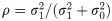
Power of CoCoNet to identify trait relevant tissues in simulations.(A): In scenario I, we selected one of the ten tissues as the trait-relevant tissue (second row) and simulated gene-level effect measurements based on the adjacency matrix (first row). We treated the adjacency matrices all as observed (third row) and fit the model using each of the ten matrices. (B): In scenario II, the data are generated in the same way as in scenario I but we fit the model using tissue-specific matrices that are noisy versions of the truth (third row). In particular, we assumed that each connected gene pair in the true adjacency matrices has a probability of p being un-observed, and each unconnected gene pair has a probability q to be falsely assigned as connected. (C): In scenario III, the data are again generated in the same way as in scenario I but we fit the model using tissue-specific matrices that are noisy versions of the truth (third row). In particular, we randomly converted a proportion q of unconnected gene pairs in the true adjacency matrix to be connected. (D): The power of CoCoNet for identifying the correct tissue (y-axis) increases with increasing signal strength measured by ρ=σ12/(σ12+σ02) (x-axis) in scenario I. (E): The power of CoCoNet for identifying the correct tissue (y-axis) gradually decreases with increasing noise level characterized by p (x-axis) in scenario II. (F): The power of CoCoNet for identifying the correct tissue (y-axis) gradually decreases with increasing noise level characterized by q (x-axis) in scenario III.